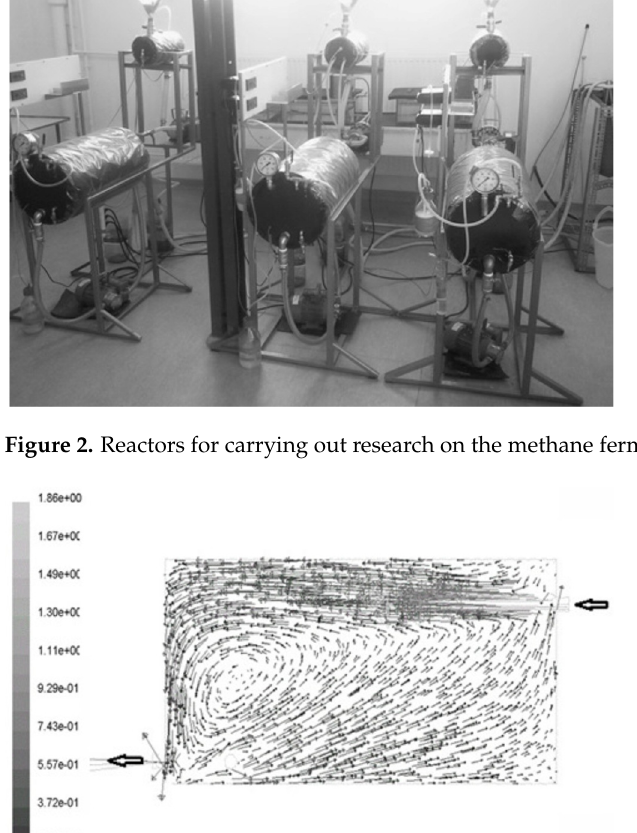
Figure 2. Reactors for carrying out research on the methane fermentation process.